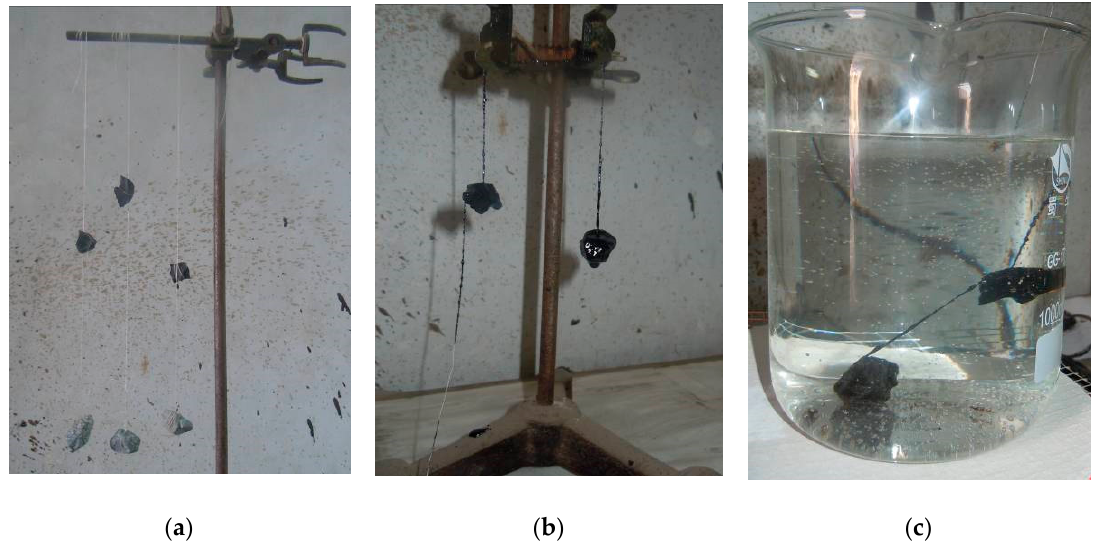
Figure 2. The test procedure for the boiling of minerals and rubber crumbs: ( a ) test preparation; ( b ) suspension cooling; and ( c ) boiling process.